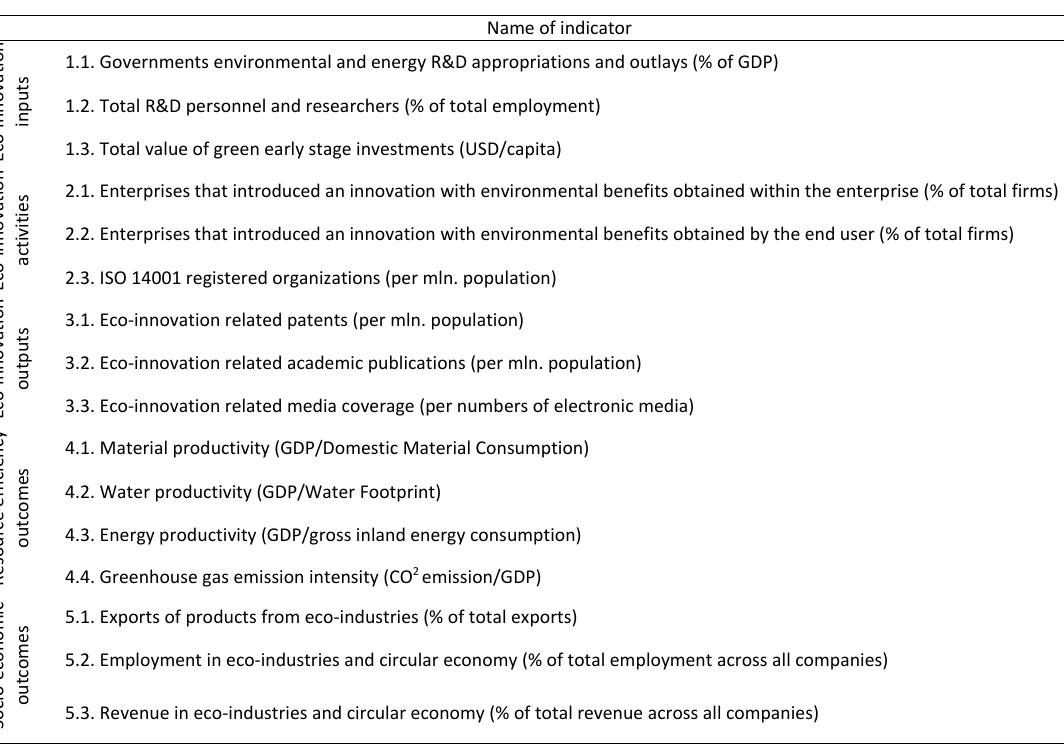
Table 2: Indicators used in the 2017 version of the Eco-Innovation Scoreboard (Eco-IS)